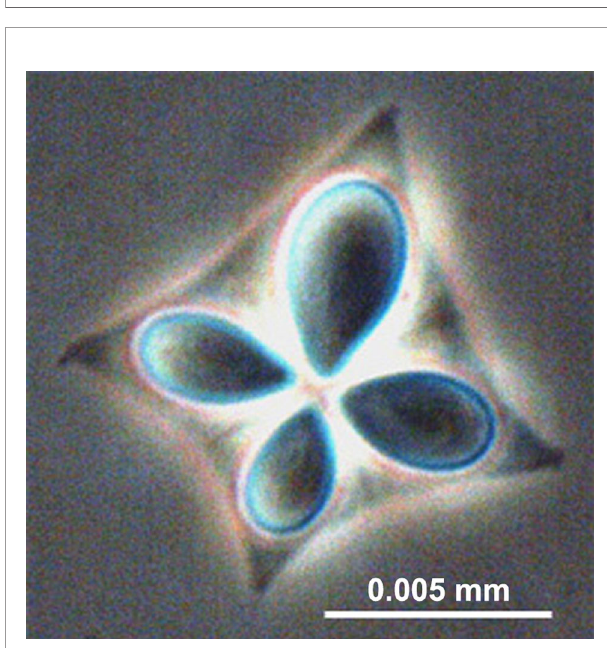
FIGURE 3 | A single spore of Kudoa thyrsites with four nematocysts (polar capsules) clearly visible. (phase contrast. Levsen,